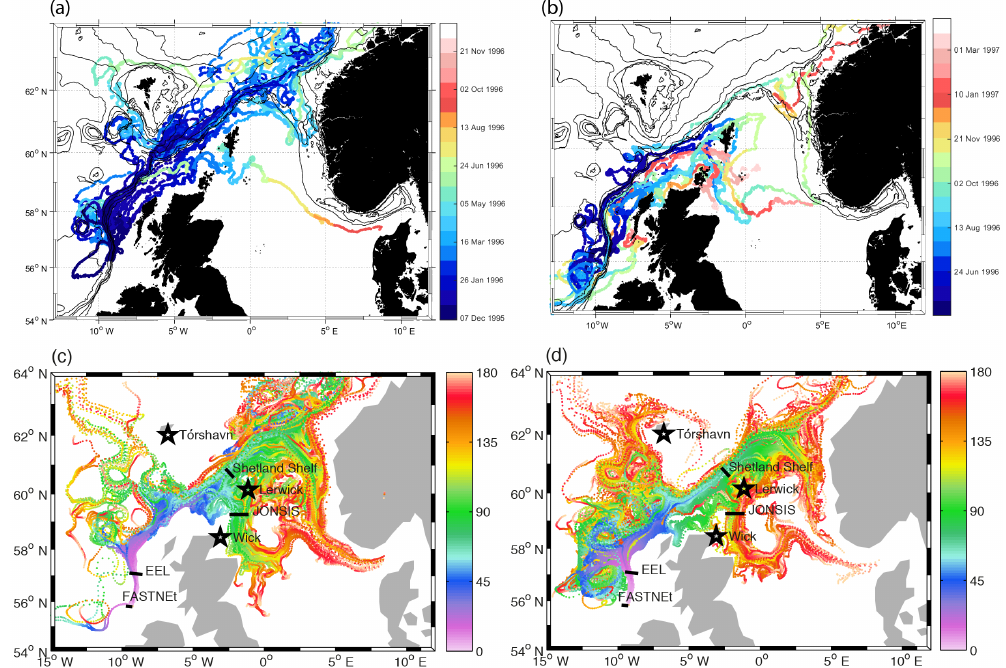
Figure 1. Drogued drifters released in (a) December 1995 and (b) May 1996; model particle trajectories spanning 6 months, released on (c) 1 January 1996 and (d) 1 July 1996 (630 model trajectories are plotted in each case). Drifters are colour-coded by calendar date. Model particles are colour-coded by age (days). Note that the drifter data span slightly different durations: up to 11 months, December 1995– November 1996 (a) ; up to 10 months, May 1996–March 1997 (b) . In (c) and (d) , we also indicate the FASTNEt, EEL and Shetland Shelf sections where we sample the Slope Current, the western JONSIS line where we sample the Fair Isle Current, and the locations of Wick, Lerwick and Tórshavn where we take the sea surface height records used to develop proxies for variability of transport in the Slope Current and the Fair Isle